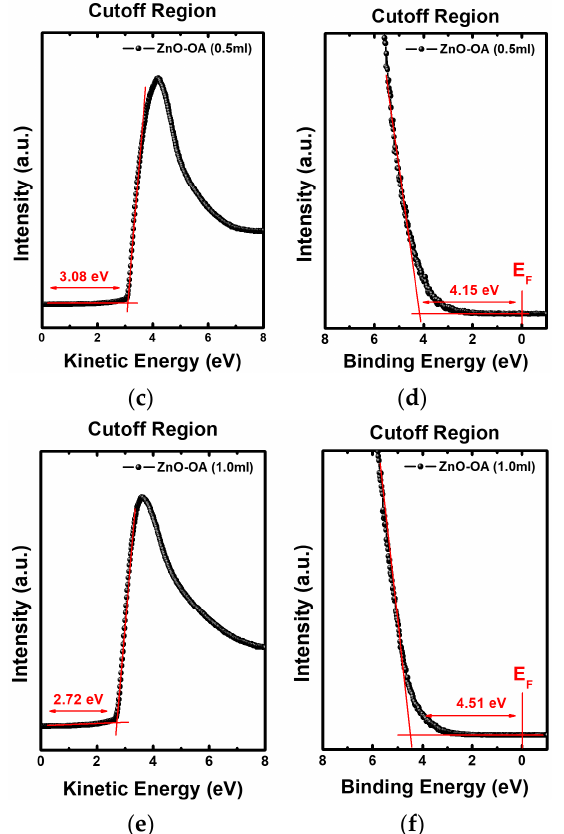
Figure 8. Secondary cutoff region of ( a ) ZnO QDs, ( c ) ZnO-OA (0.5 mL) QDs, and ( e ) ZnO-OA (1.0 mL), and valence region of ( b ) ZnO QDs, ( d ) ZnO-OA (0.5 mL) QDs, and ( f ) ZnO-OA (1.0 mL) QDs in UPS.